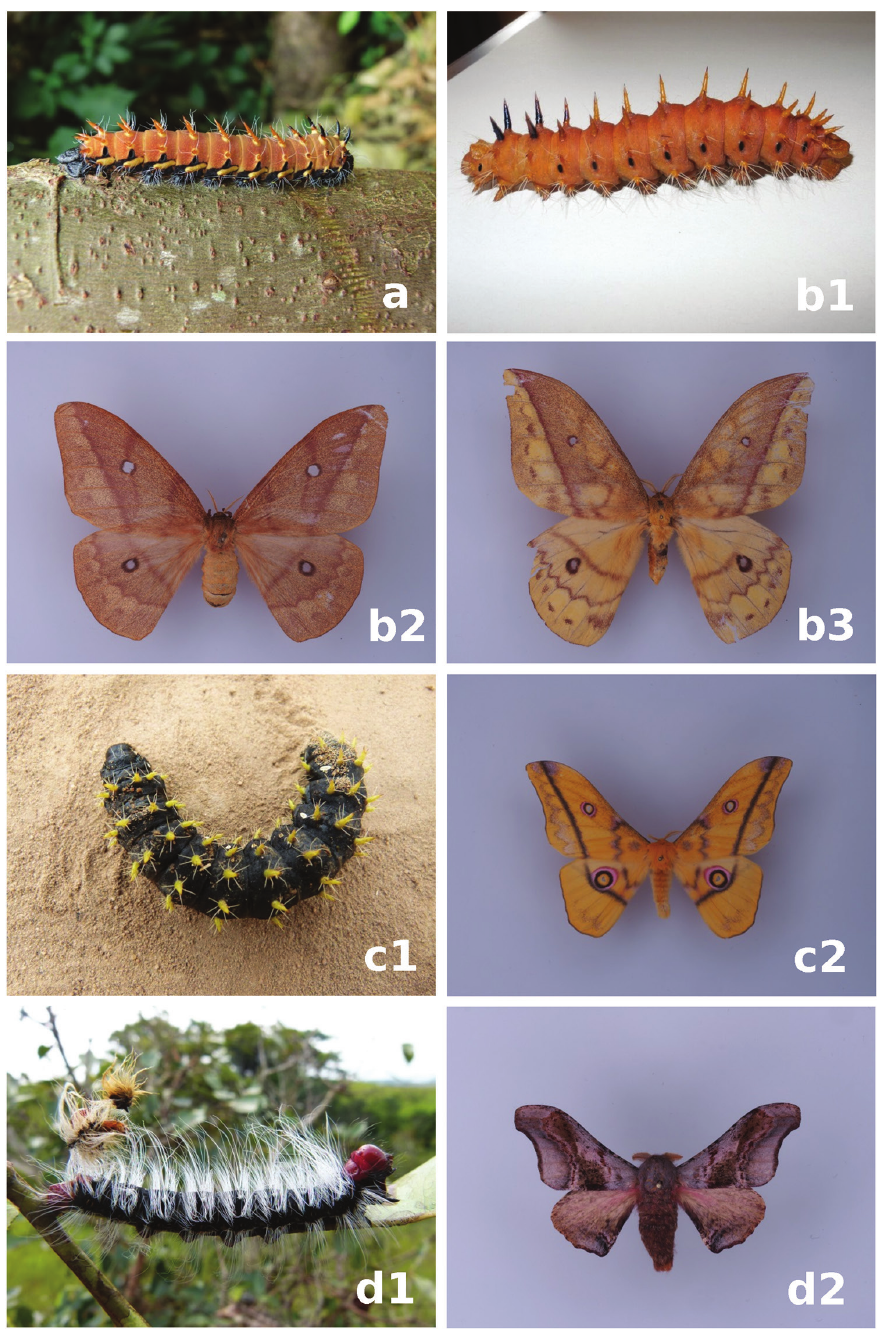
Figure 3. Photographs of another 4 edible Saturniidae-larvae collected in the Province Uíge and its ima- goes. a larva of Gonimbrasia alopia b Pseudantheraea discrepans (1) larva, (2) female imago (3) male imago c Gonimbrasia dione (1) larva, (2) male imago d Micragone cana (1) larva, (2) male imago